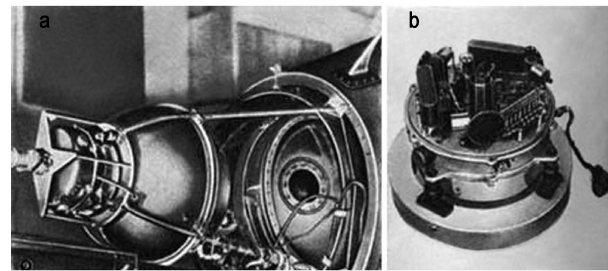
Figure 15. Sputnik 2 (a) appearance and (b) instrument compart- ment (Petrukovich et al.,